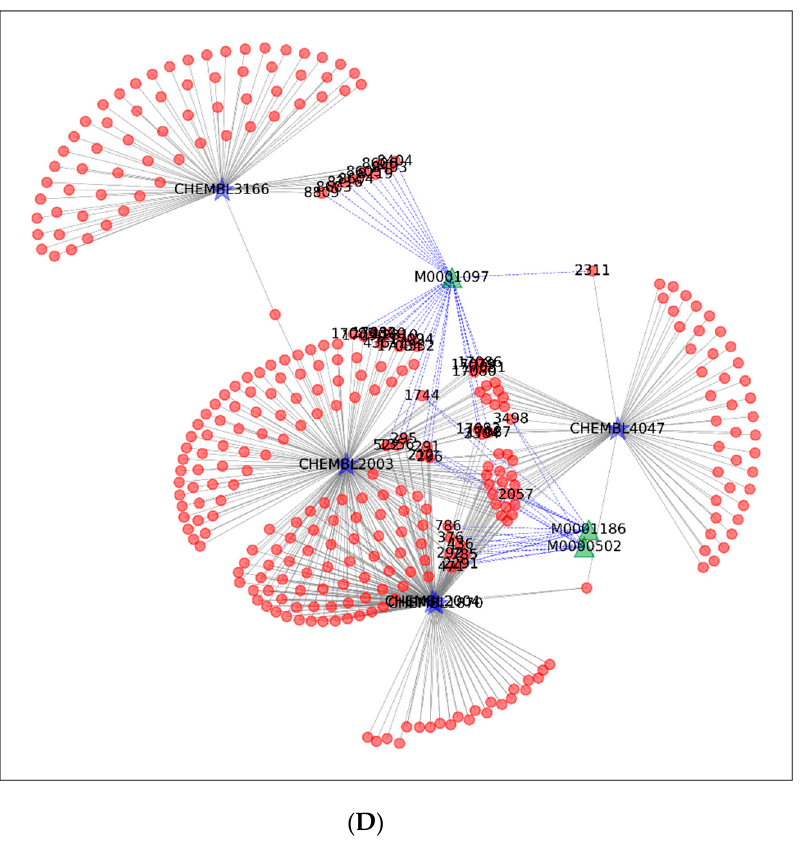
Figure 3. ( A ) The network diagram for the plants cluster in Figure 2A and the 6 targets retrieved based on the TPS index greater than or equal to 0.1. The chemicals effective to the targets are depicted in red circles. ( B ) The network diagram for the plants cluster in Figure 2C and the 2 targets retrieved based on the TPS index greater than or equal to 0.5. The chemicals effective to the targets are depicted in red circles. ( C ) The network diagram for the plants cluster in Figure 2E and the 7 targets retrieved based on the TPS index greater than or equal to 0.05. The chemicals effective to the targets are depicted in red circles. ( D ) The network diagram for the plants cluster in Figure 2G and the 5 targets retrieved based on the TPS index greater than or equal to 0.05. The chemicals effective to the targets are depicted in red circles.